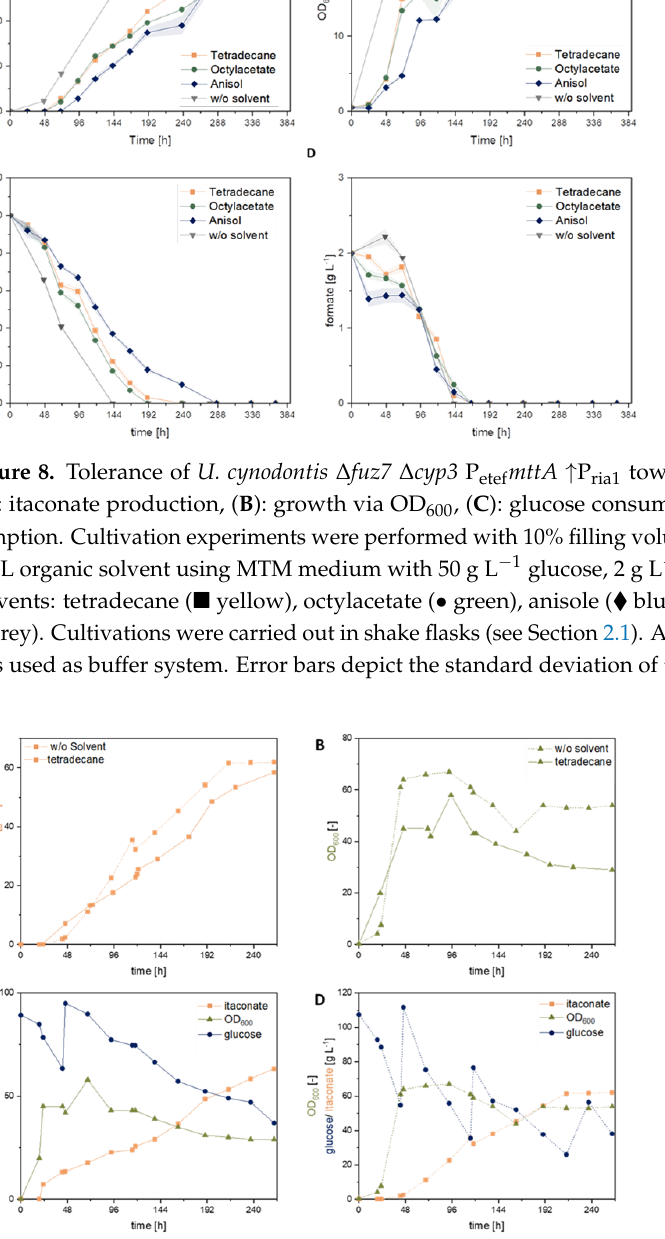
Figure 9. Itaconate production in pulsed fed-batch bioreactor using commercially available sodium formate and formate solutions obtained from biphasic CO 2 hydrogenation (catalyst phase: tetrade- cane). U. cynodontis ∆ fuz7 ∆ cyp3 P etef mttA ↑ P ria1 was used in these experiments. ( A ): itaconate production (cid:4) , ( B ): growth via OD 600 (cid:78) , ( C ): process parameters of cultivation with catalytic product (solid line) and ( D ): cultivation with commercial sodium formate (dashed line). Glucose consump- tion was visualized via • . Cultivation was performed with a controlled bioreactor set-up (500 mL filling volume) using MTM medium with 100 g L − 1 glucose, 4 g L − 1 sodium formate, 3.5 g L − 1 NH 4 Cl and MES buffer. pH was controlled at 6.5 via addition of NaOH and HCl (30 ◦ C, 80% DO, n = 1). Color scheme is determined as itaconate (orange), OD600 (green), glucose (blue) and formate concentration